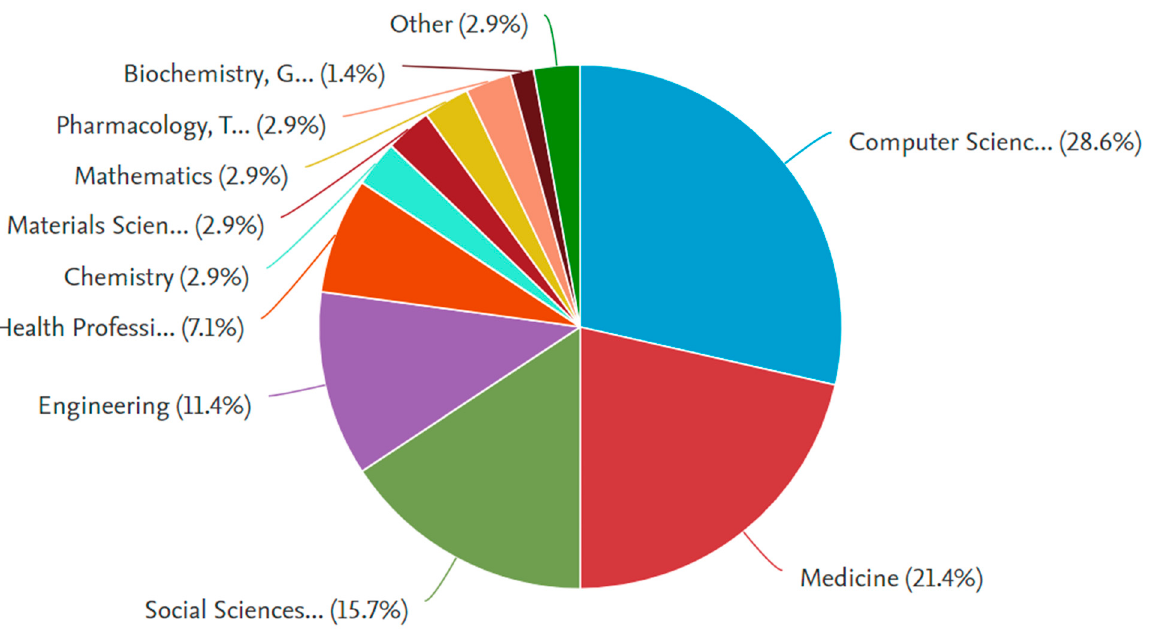
Figure 1. Documents’ distribution by thematic area, concerning CC and F.